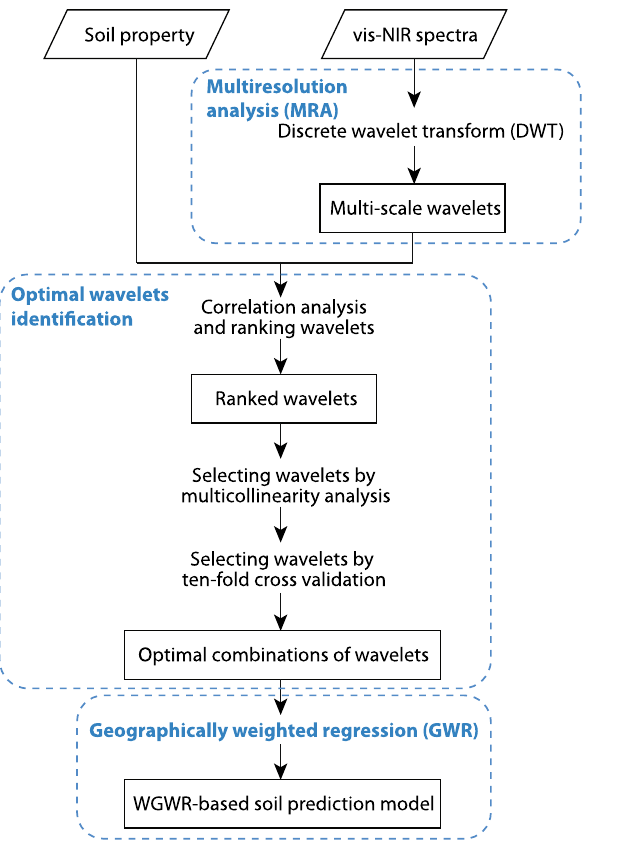
Figure 7. Flowchart of the wavelet geographically weighted regression (WGWR) model for soil